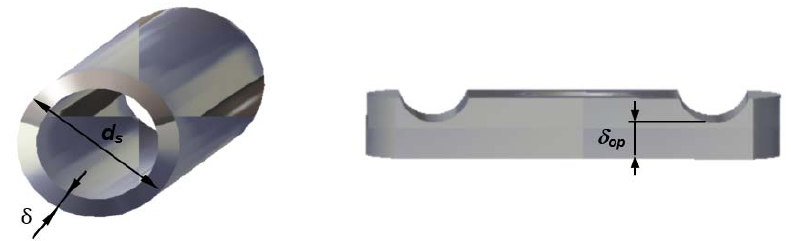
Figure 3. Referent design parameters.